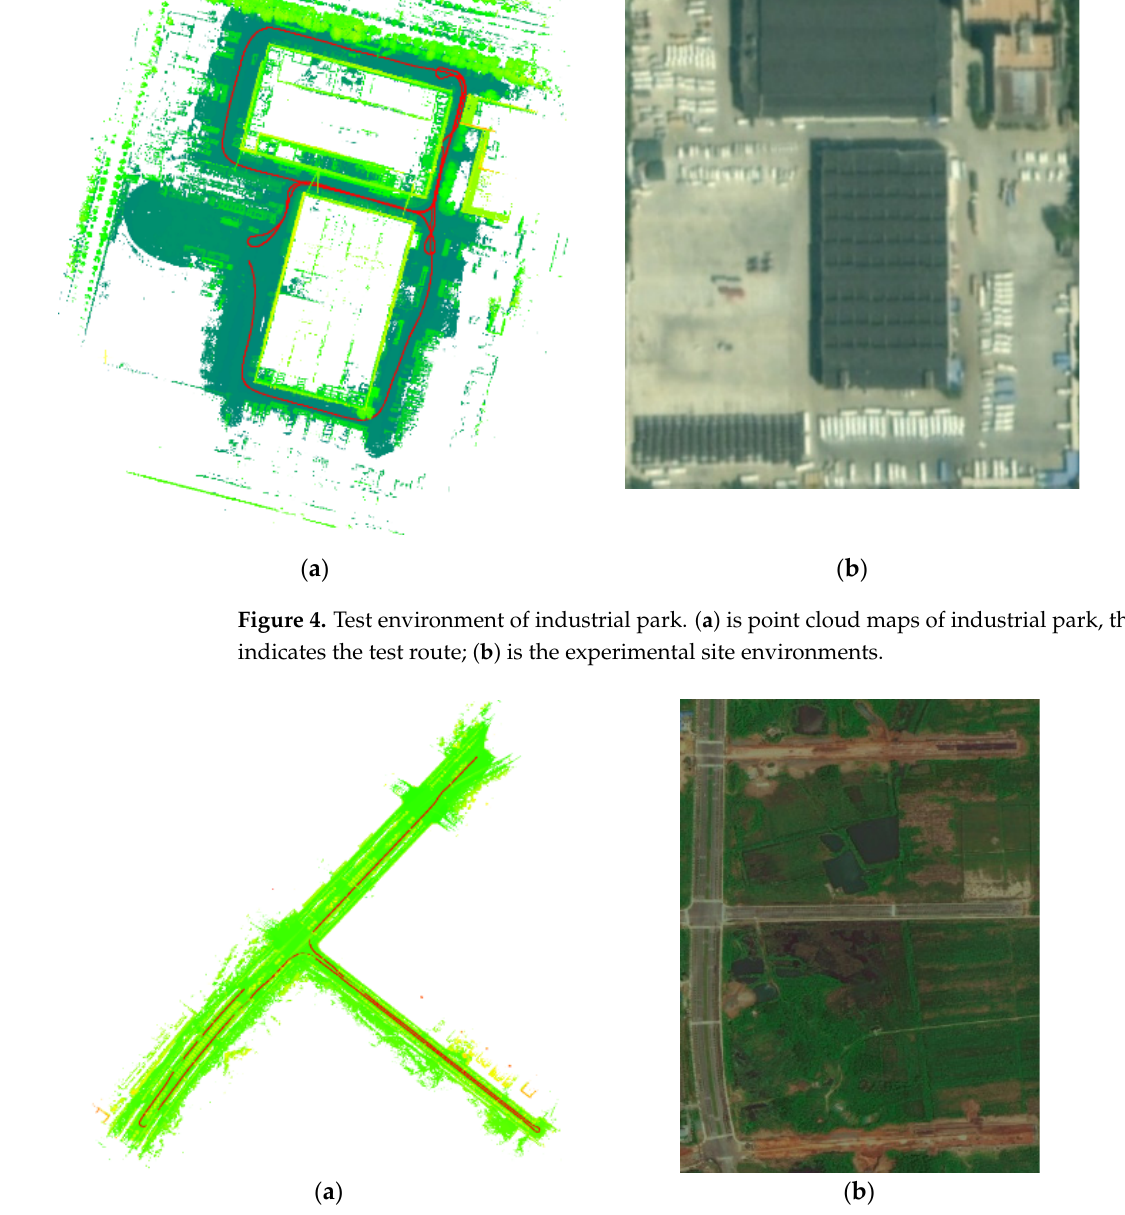
Figure 5. Test environment of road environment. ( a ) is the point cloud maps of road environment, the red line indicates the test route; ( b ) is the experimental site environments.